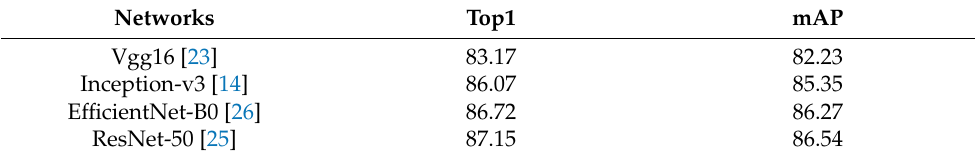
Table 3. Mineral recognition results based on classical deep-learning backbone networks